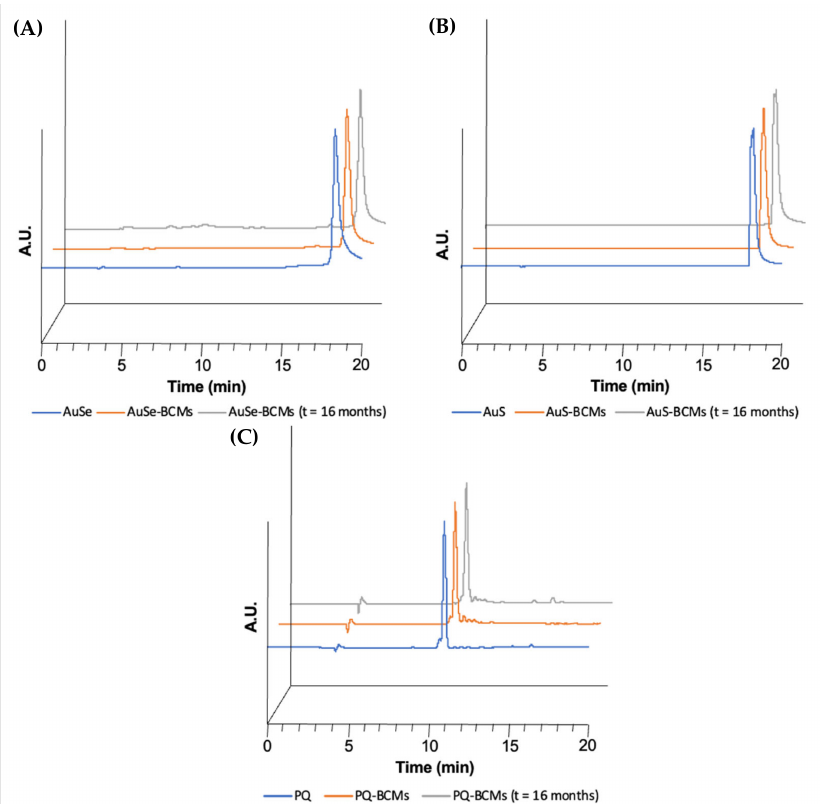
Figure 5. HPLC chromatograms of ( A ) AuSe (R t = 18.35 min), AuSe-BCMs immediately after the preparation (R t = 18.35 min), and AuSe-BCMs after 16 months (R t = 18.45 min) with UV detection at 290 nm; ( B ) AuS (R t = 18.24 min), AuS-BCMs immediately after the preparation (R t = 18.15 min) and AuS-BCMs after 16 months (R t = 18.19 min) with UV detection at 290 nm; and ( C ) PQ (R t = 11.05 min), PQ-BCMs immediately after the preparation (R t = 11.04 min) and PQ-BCMs after 16 months (R t = 10.96 min) with UV detection at 272 nm.